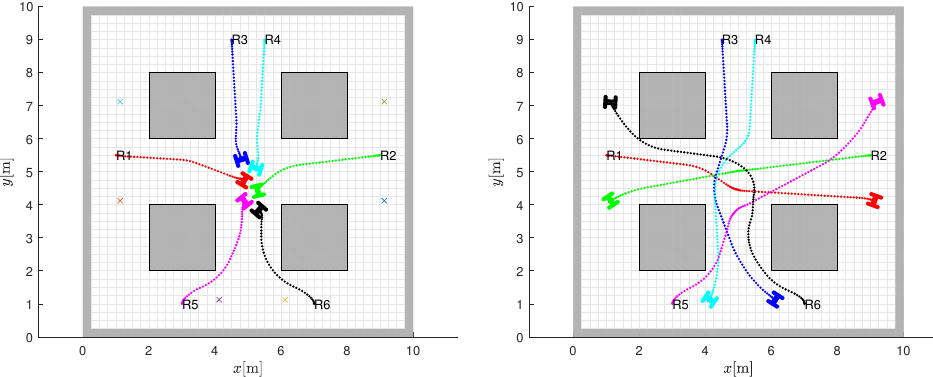
Figure 12. The obtained control with avoidance and prediction horizon h = 15 cannot steer the robots towards the destinations since the robots stop safely to prevent collision (left image). Increasing the horizon to h = 25 leads to safe trajectories towards the target locations (right